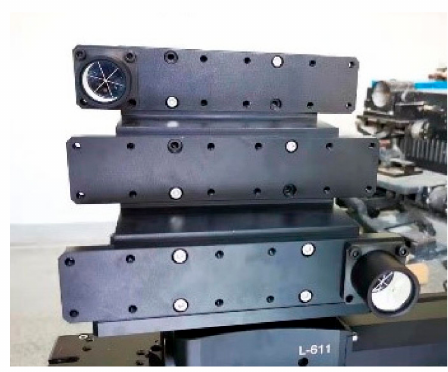
Figure 26. Optical picture of targets.